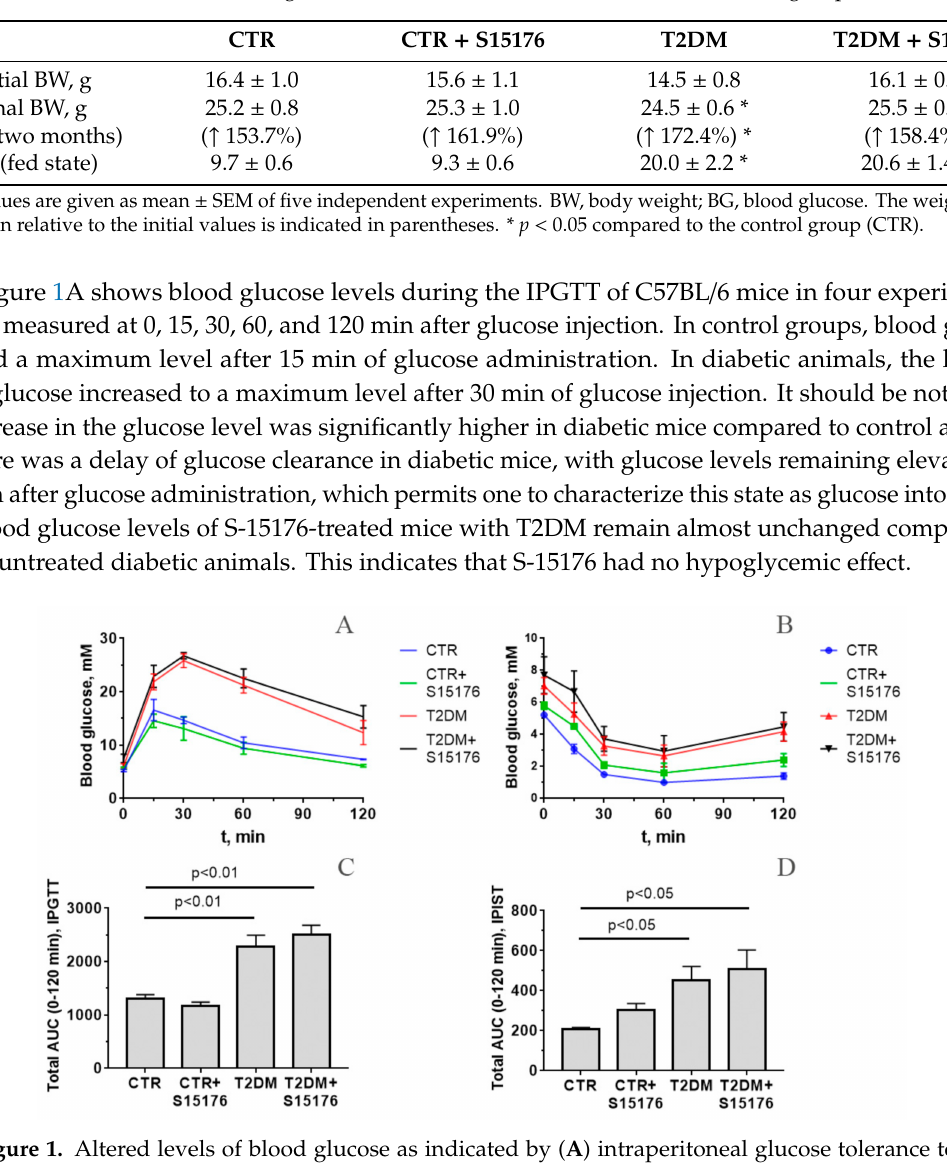
Table 2. Animal weights and biochemical characteristics in the studied groups.